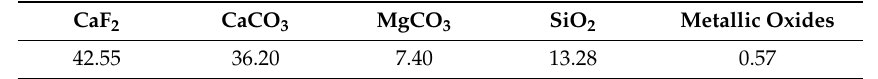
Table 2. Analysis of fluorite slime sludge based on standard UNE-7-307-86 (data as mass fraction, %).